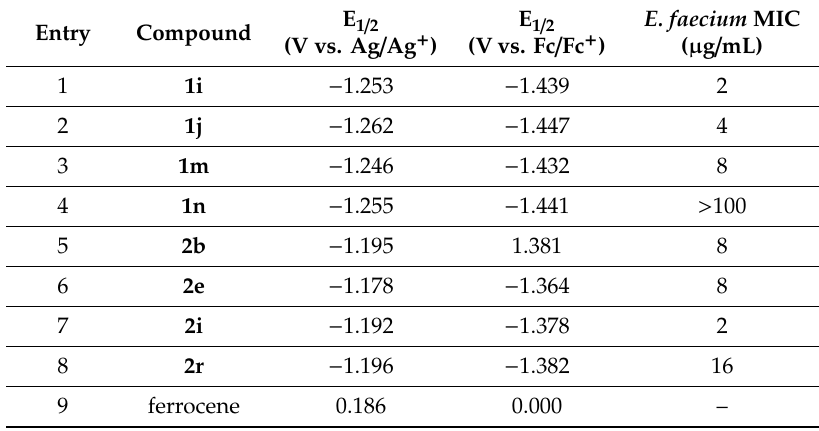
Table 4. Reduction potentials (E 1 / 2 , V) of selected compounds 1 and 2 and their MIC values ( µ g / mL) observed against E. faecium